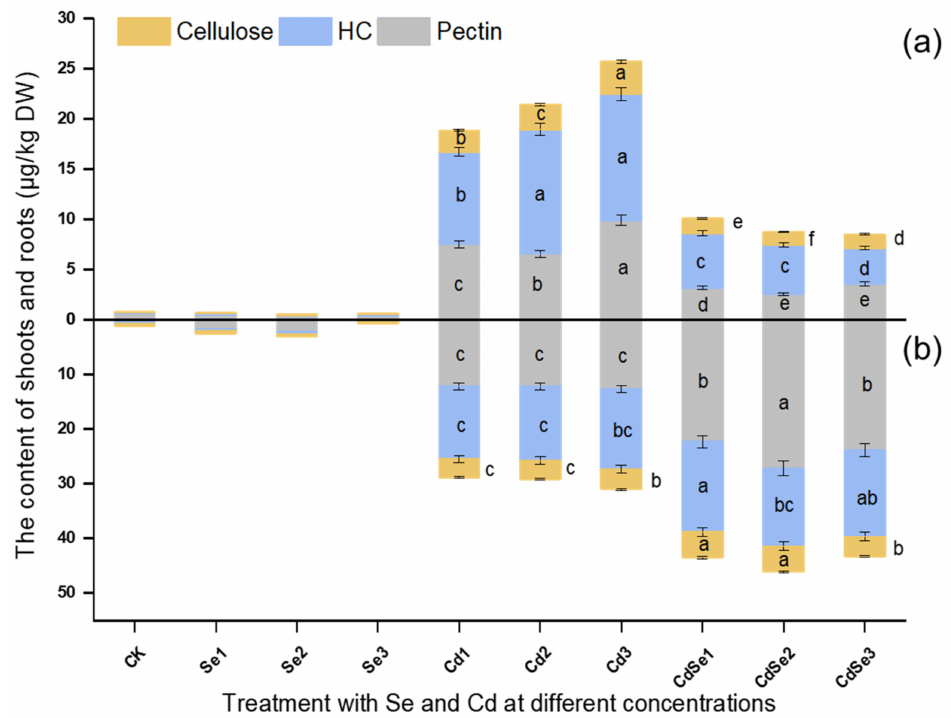
Figure 7. The distribution of Cd in different components of the CW of B. juncea in the shoots and roots after treatment with different concentrations of CdCl 2 and Na 2 SeO 3 . Cellulose—the Cd content in the cellulose of the CW; HC—the Cd content in the hemicellulose of the CW; pectin—the Cd content in the CW of pectin. The error bar represents the standard deviation. The lowercase letter a to f on the bar reflects the 5% significance level. ( a ) Distribution of Cd in the CW of the shooting part; and ( b ) distribution of Cd in the CW of the root